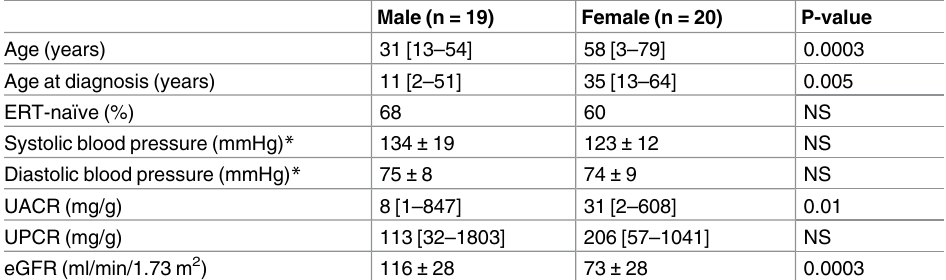
Table 2. Comparison of clinical characteristics in male and female